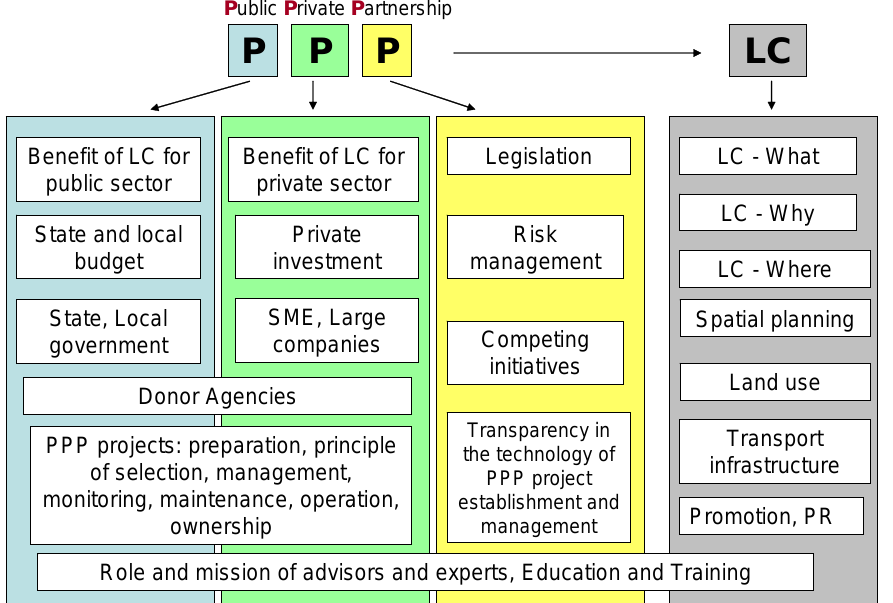
Fig. 2. Th e main tasks for creation of